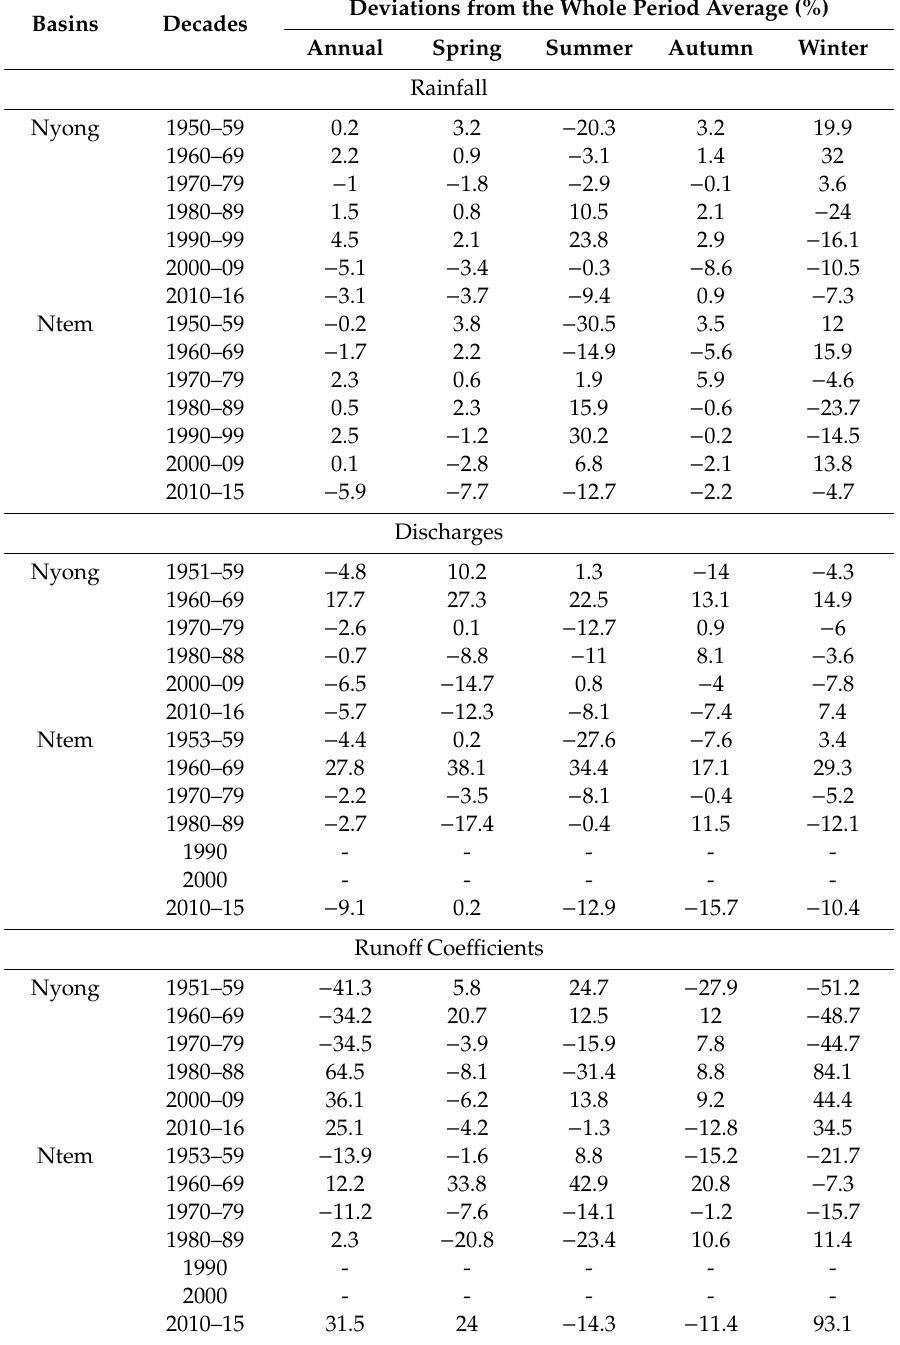
Table 3. Deviations (%) of decadal annual and seasonal averages of rainfall, discharges and runo ff coe ffi cients compared to the whole period averages of the studied